Question: Write a single sentence explaining what this figure depicts.
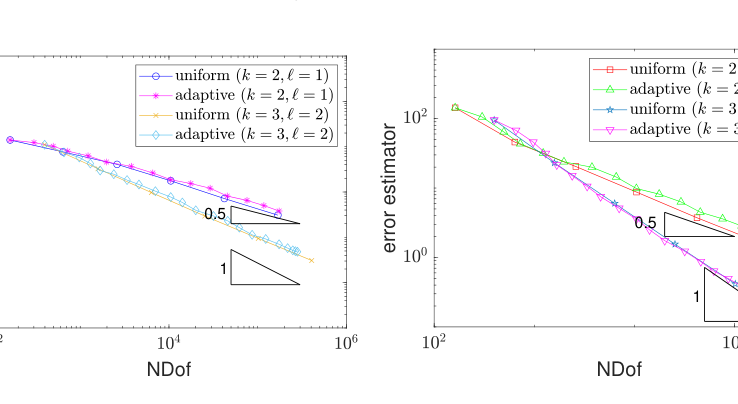
Answer: Left (resp. right) panel displays NDof vs error in en- ergy norm (resp. error estimator) in both uniform and adaptive reﬁnements for nonconforming VEM.